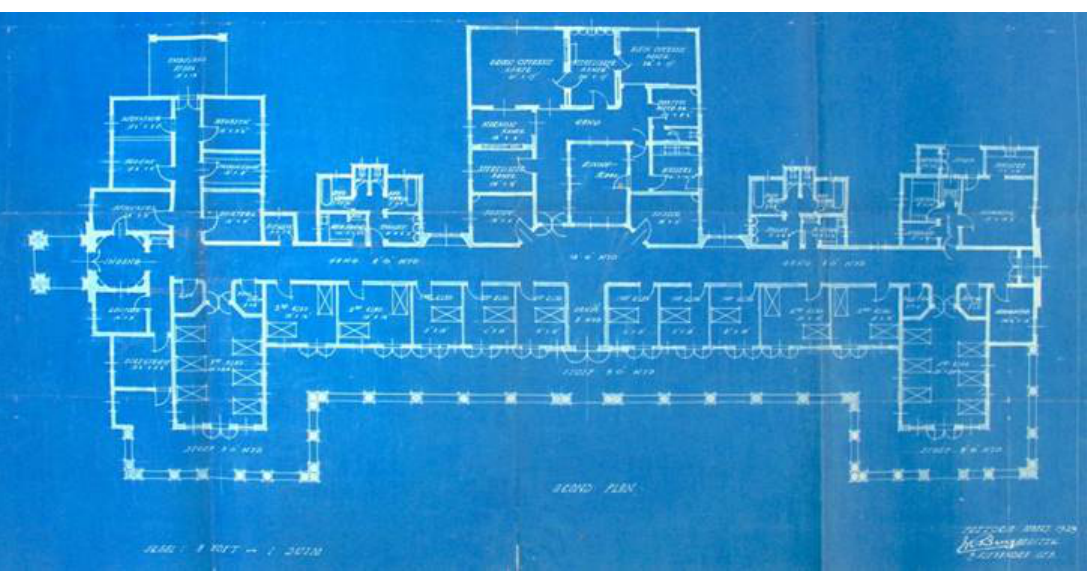
Figure 2. Floor plan of Johan R. Burg’s first design for the Zuid Afrikaans Hospital in Pretoria, 1929, with veranda to the north (Source: Hanrath Collection, Het Nieuwe Instituut, Rotterdam, HANR0406,